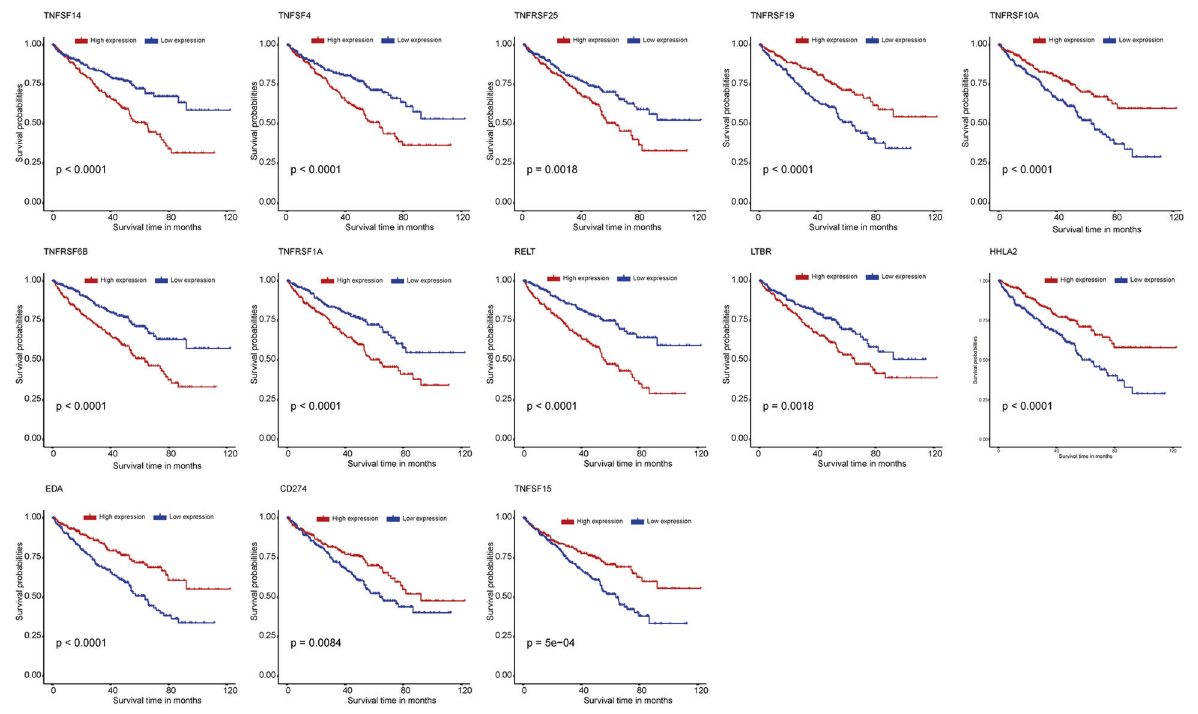
Fig. 2 Survival analysis for thirteen costimulatory molecule genes. The Kaplan-Meier curves for the thirteen costimulatory molecule genes in clear cell renal cell carcinoma from The Cancer Genome Atlas dataset, including TNFSF14, TNFSF4, TNFRSF25, TNFRSF6B, TNFRSF1A, RELT, LTBR,TNFRSF19, TNFRSF10A, HHLA2, EDA, CD274, and